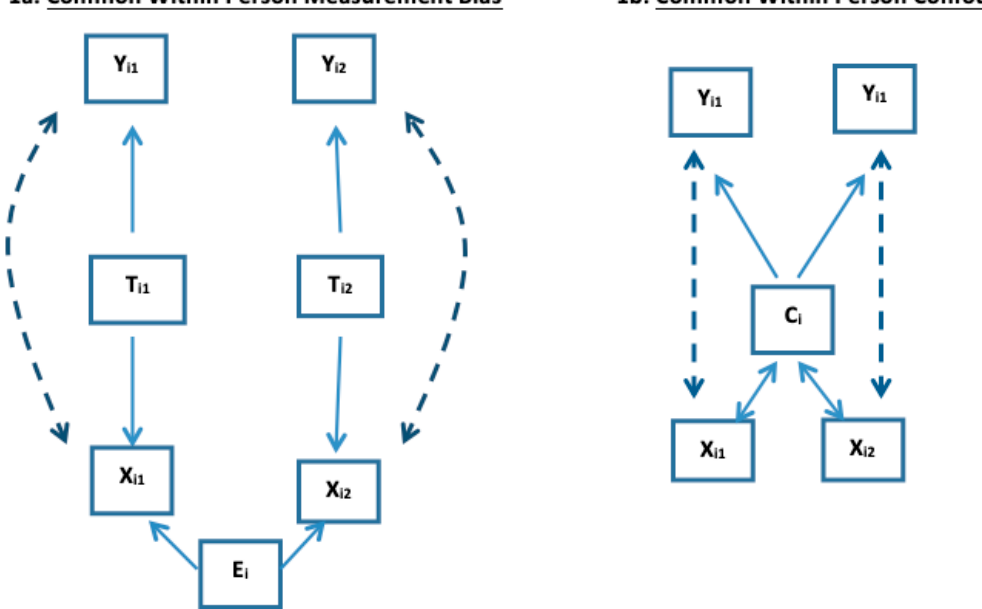
Figure 1. Illustration of common within ‐ subject measurement bias and confounding for K = 1.